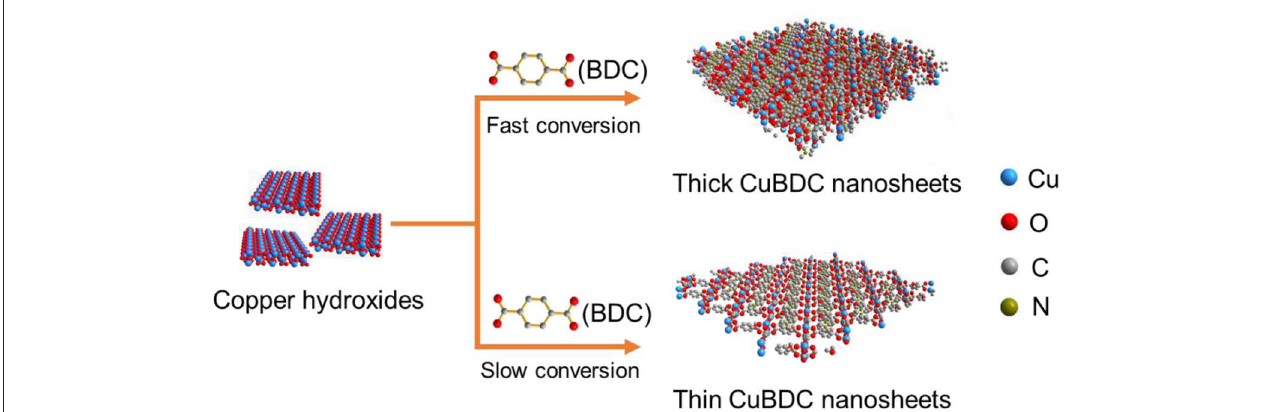
FIGURE 1 | Scheme illustration of the controllable synthesis of CuBDC nanosheets with different thickness by using metal hydroxide precursor approach.